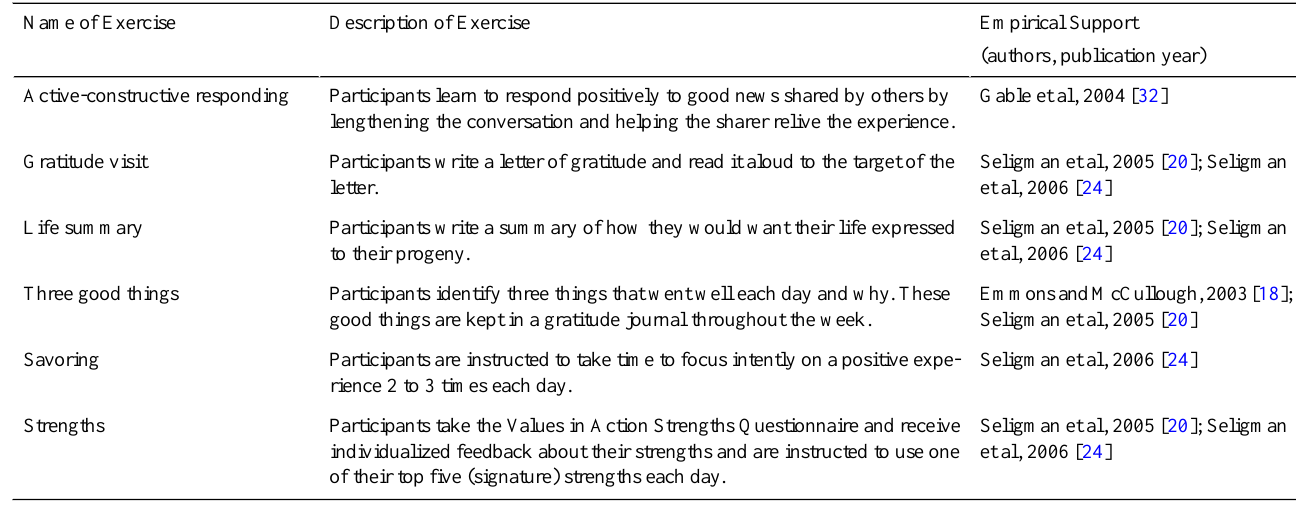
Table 1. Descriptions of individual